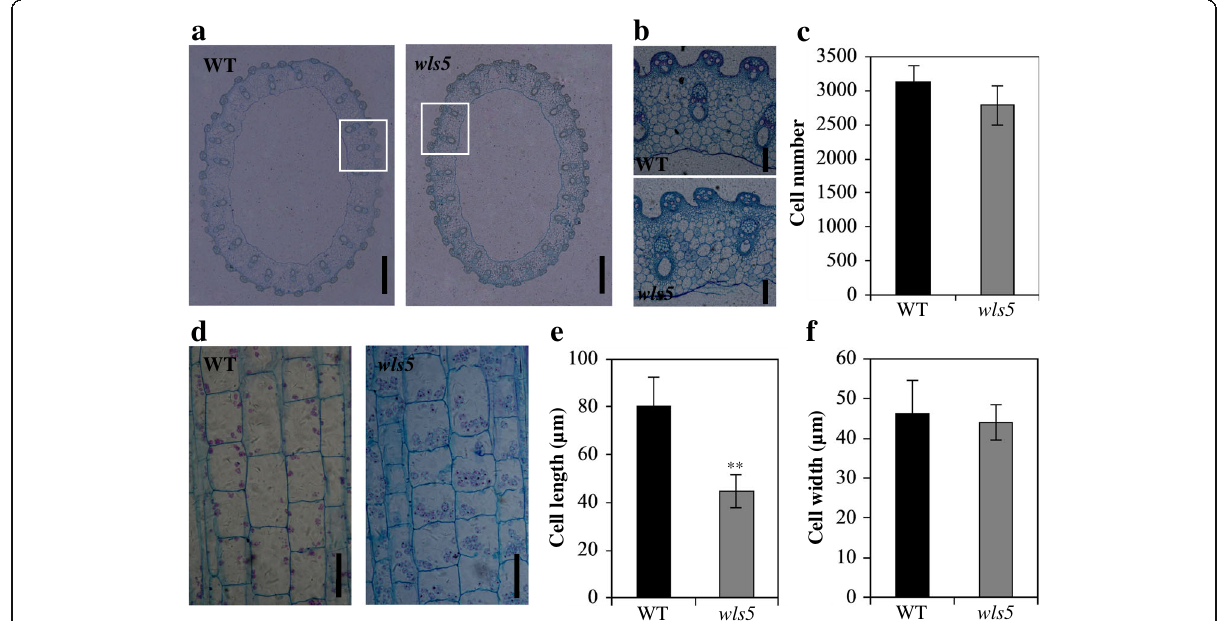
Fig. 2 Histological characterization of culms in wild-type (WT) and wls5 plants. a Cross sections of internode II of WT ( ‘ 93 – 11 ’ ) and wls5 plants at heading stage. b Magnification of a. Bars = 500 μ m ( a ), 50 μ m ( b ). c Statistical analysis of cell number between WT and wls5 plants; means ± SD of five independent replicates. d Longitudinal sections of internode II of WT and wls5 plants. Bars = 50 μ m. e - f Statistical analysis of cell length and cell width between WT and wls5 plants; means ± SD of 30 cells. ** P < 0.01 (Student ’ s t- test)